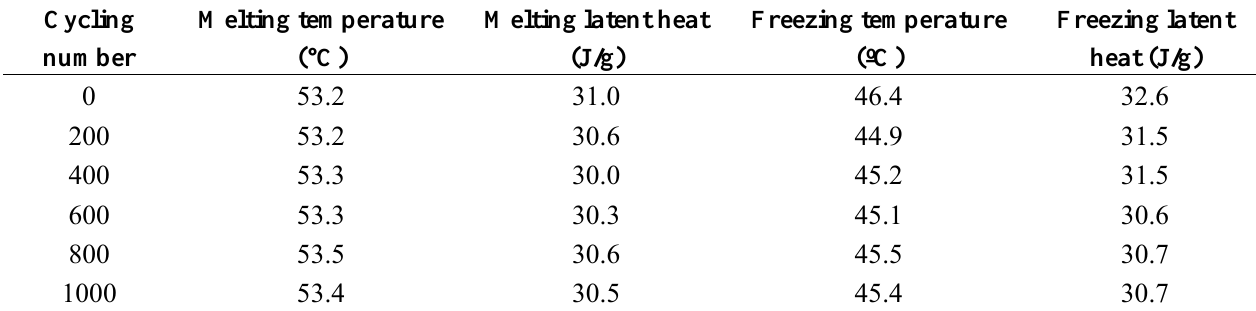
Table 1. DSC result of the microencapsulated paraffin wax, S1.